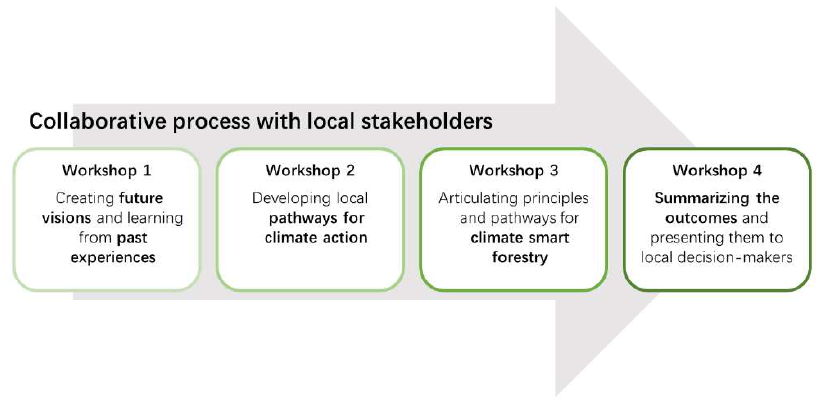
Figure 1. The set-up of the transdisciplinary collaborative process in the “Bring down the sky to earth” project, of which this study reports output from Workshop 3.